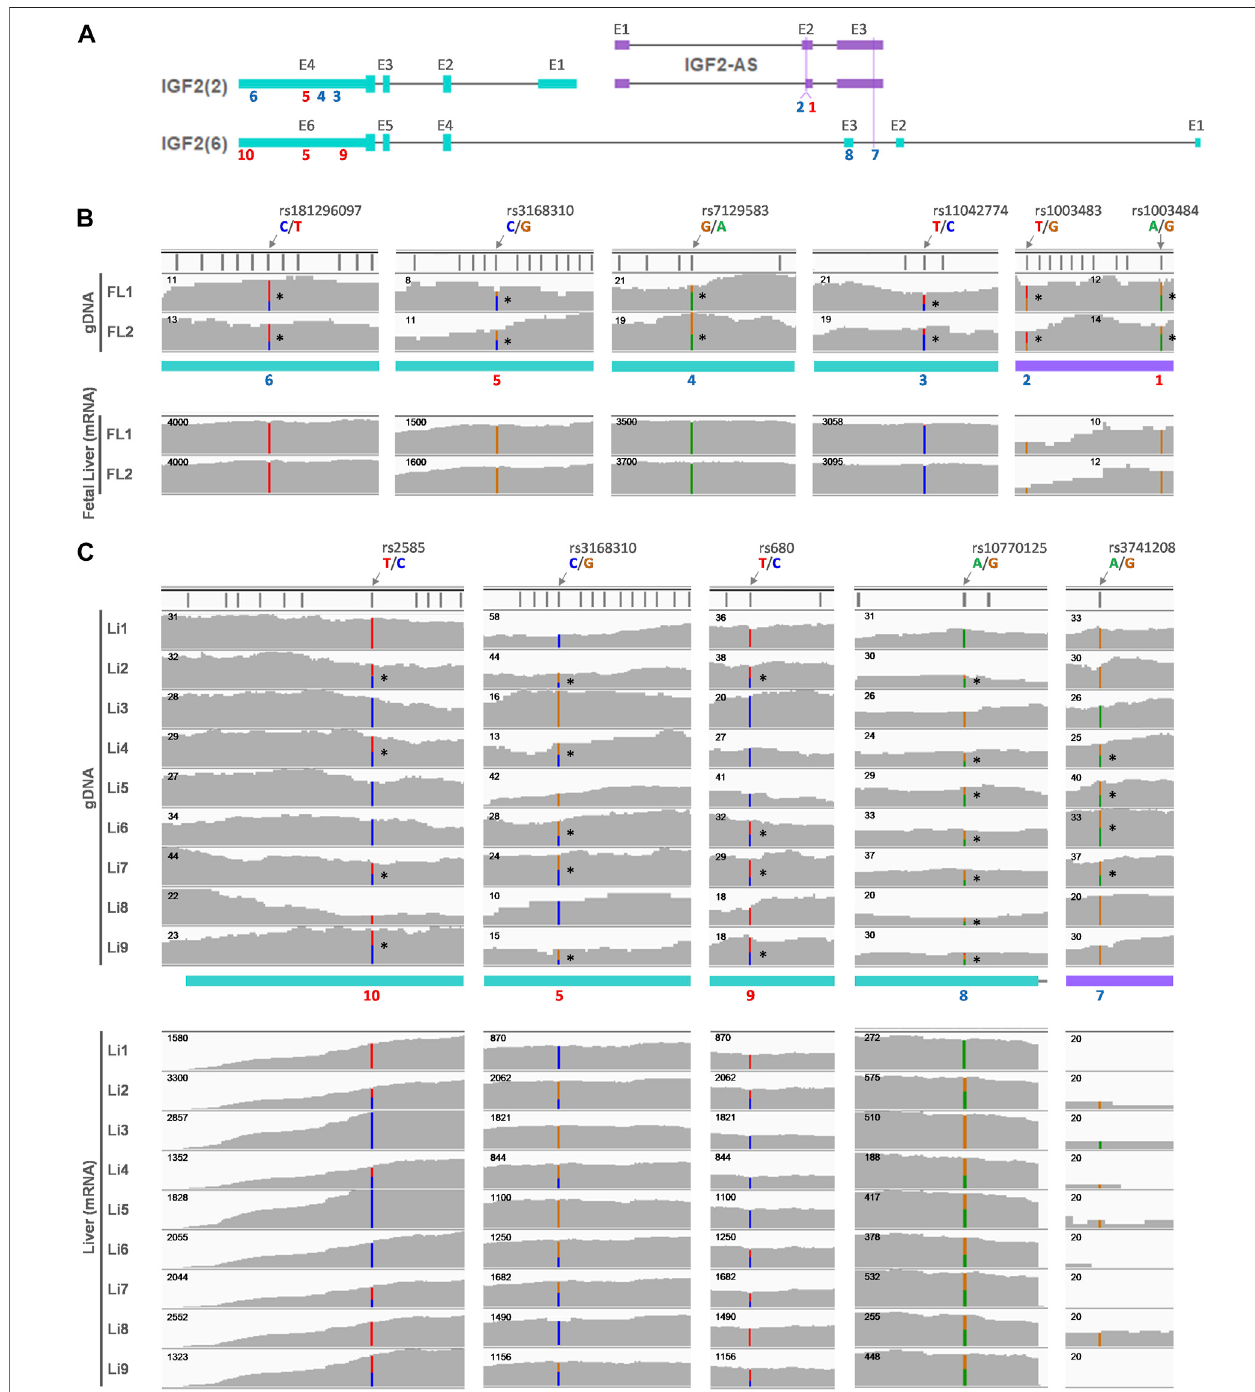
FIGURE7| Allelicexpressionof IGF2 infetalandadulthumanliver. (A) Predominant IGF2 transcriptsineitherthefetalliver(FL)( IGF2(2) )oradultliver(Li)( IGF2(6) )are displayedalongwithantisensetranscripts( IGF2-AS ).SNP locationsaremarkedwithnumbersonexons(E)andnumbersinred(5,9,and10)indicatethesameSNPsas in Figure 7 . (B) Heterozygous alleles in the gDNA were identi fi ed using H3K4me1 ChIP-seq data retried from GSE63634 for fetal liver at 12 weeks of gestation and are denoted with stars (*) on the right side of SNPs. Corresponding sites were displayed below for fetal liver mRNA expression in individual-matched RNA-seq. (C) WGS data obtained from hum0158.v2 for normal adult liver, and heterozygous alleles are marked with stars (*) on the right side of SNPs. Corresponding mRNA expression in the adult liver derived from RNA-seq from the same dataset is shown below.